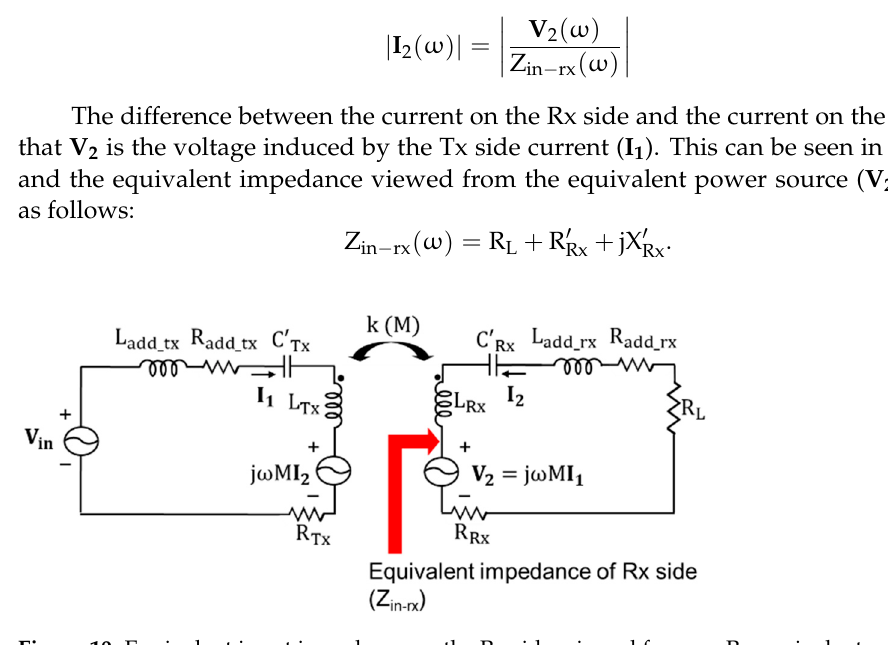
Figure 10. Equivalent input impedance on the Rx side, viewed from an Rx equivalent source.